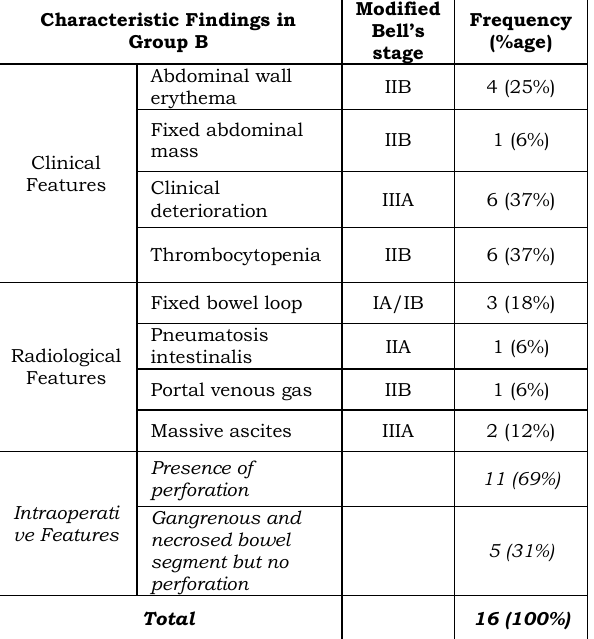
Table 3: Clinical, radiological, and operative findings in Group B patients Characteristic Findings in Group B